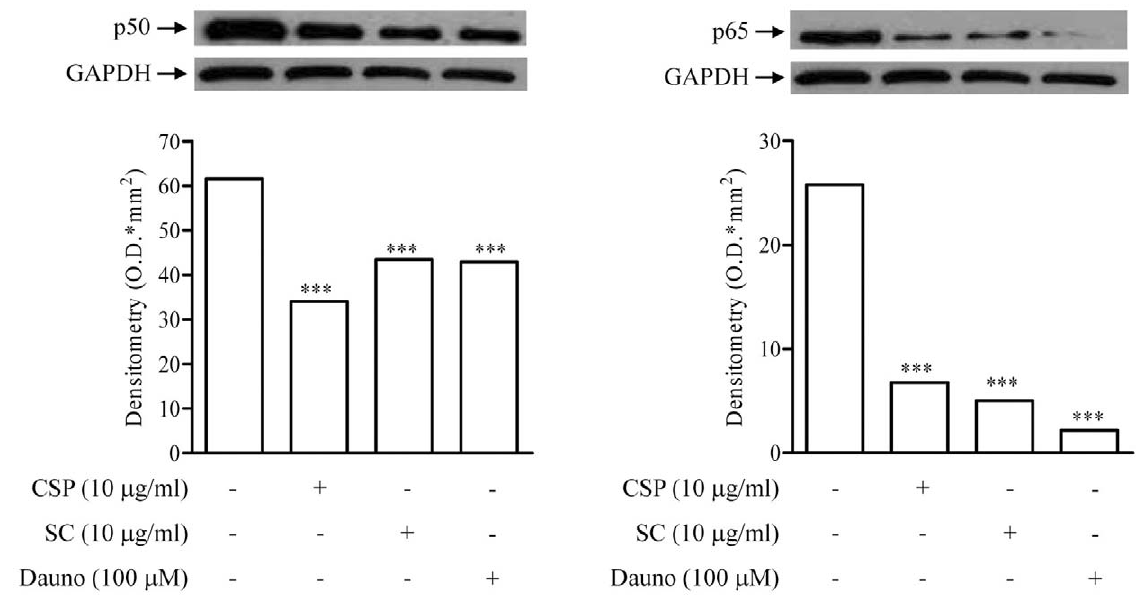
Figure 6. Effect of SC and CSP on p50 and p65 nuclear translocation. Representative Western blot of p50 and p65 as well as the densitometric analysis shows p50 and p65 nuclear translocation in T47D cells incubated with CSP (10 m g/ml) or SC (10 m g/ml) for 24 h. The results are from a single experiment and are representative of three separate experiments. Densitometric data are expressed as mean 6 S.E.M. of three separate experiments. ***p , 0.001 vs . untreated cells. The expression of GAPDH is shown as an equal loading